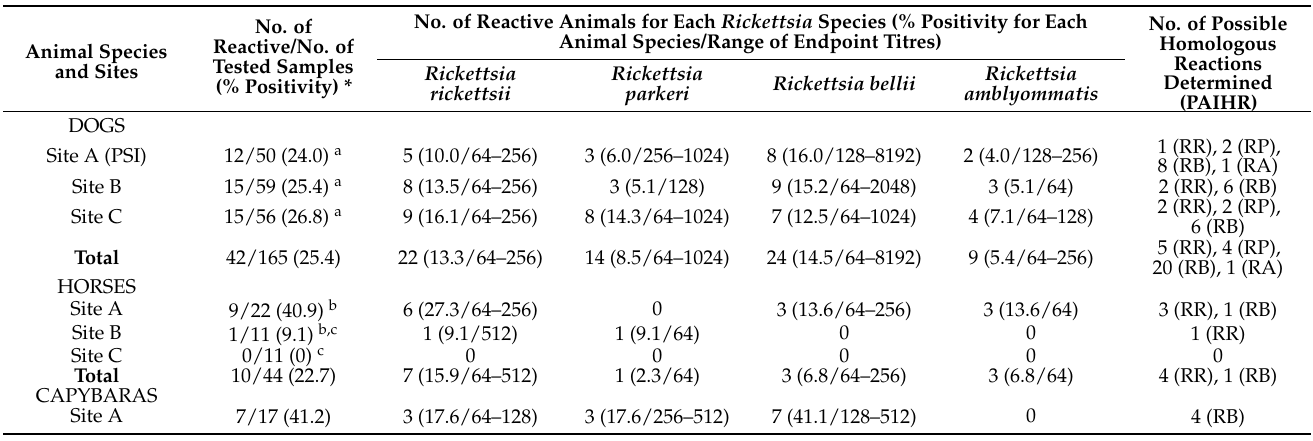
Table 1. Seroreactivity for four species of Rickettsia from animals sampled in the municipality of Goi â nia, state of Goi á s, midwestern Brazil, between March 2020 and April 2022. No. of Reactive Animals for Each Rickettsia Species (% Positivity for Each No. of Animal Species/Range of Endpoint Reactive/No. of Animal Species and Sites